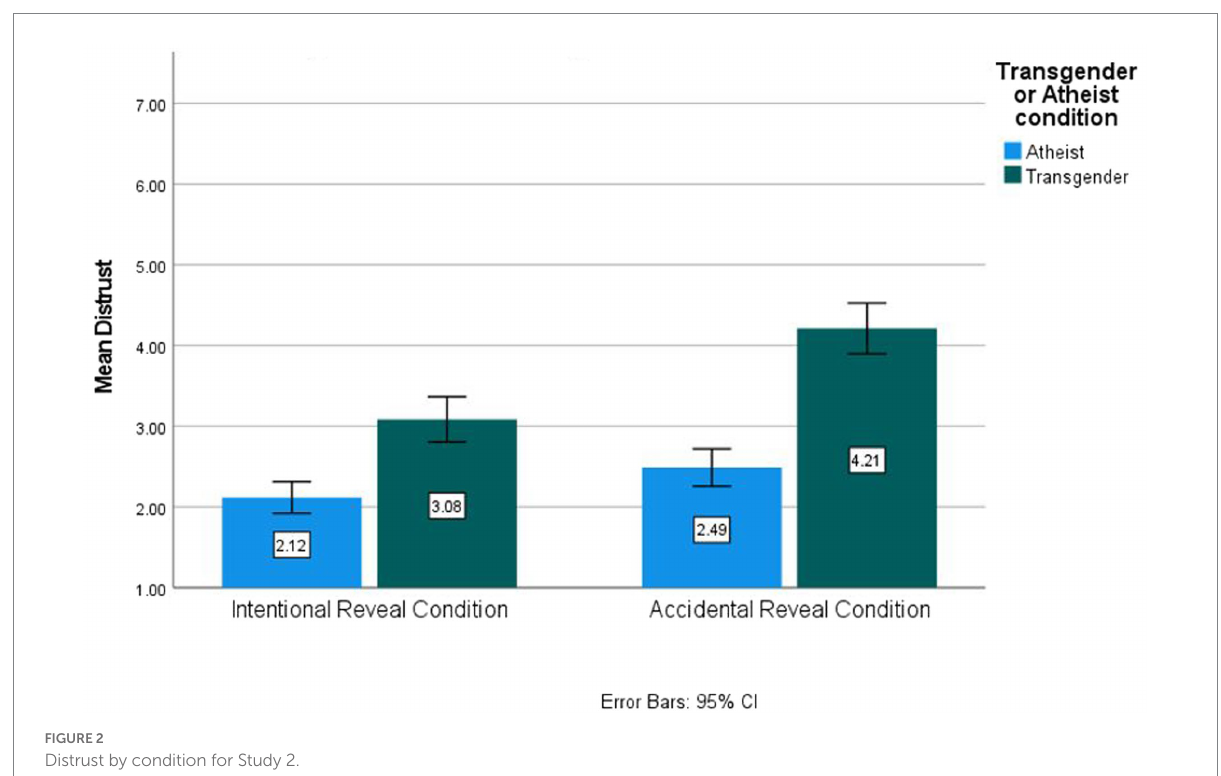
FIGURE 2 Distrust by condition for Study